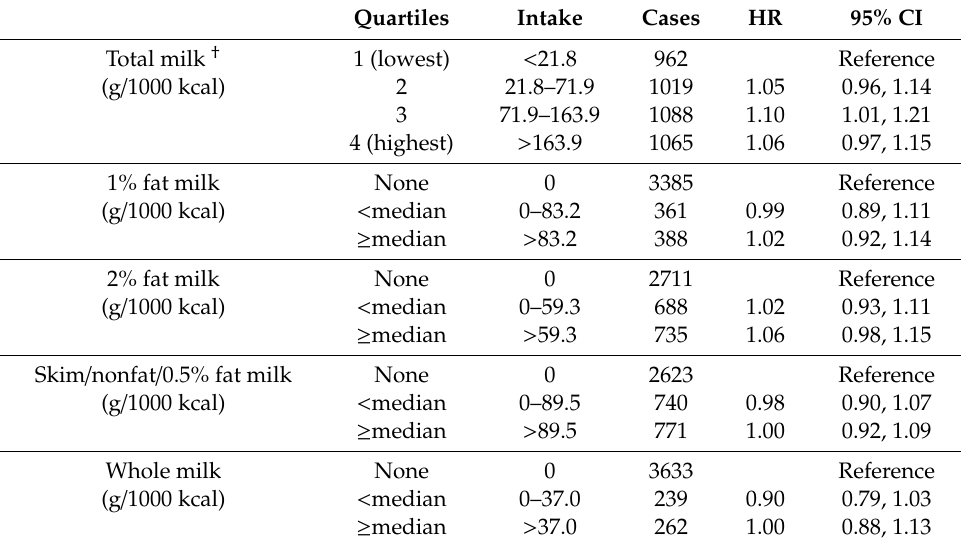
Table 3. Risk of prostate cancer by milk intake